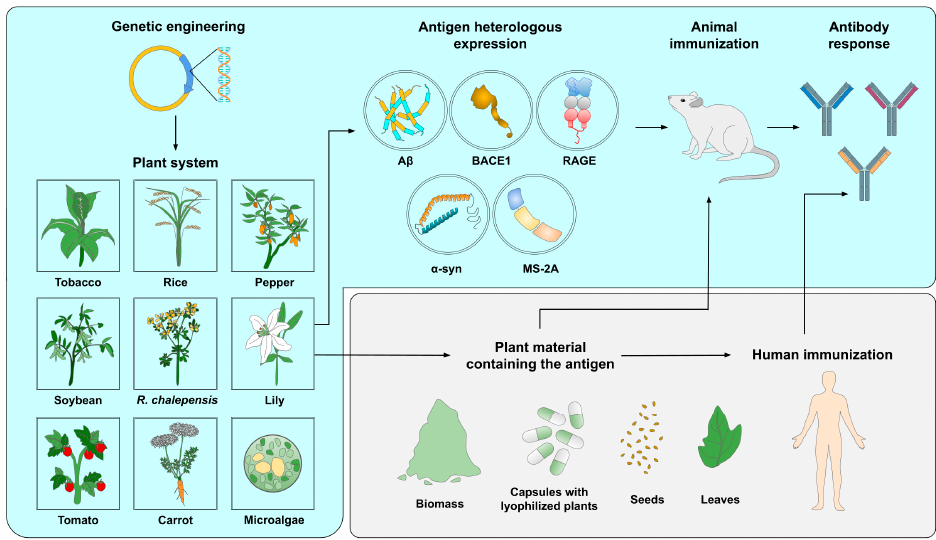
Figure 3. Production of plant-made vaccines against NDDs. Firstly, genetic engineering techniques are employed to generate plant expression systems. Upon heterologous antigen expression, animal models are immunized using either the purified antigens, seeds, plant organs, or lyophilized plants, either as biomass or encapsulated. Alternatively, at the clinical level, the goal is to be able to safely immunize humans with plant-derived vaccines, so this can result in an efficient antibody response for prevention and treatment against NDDs.